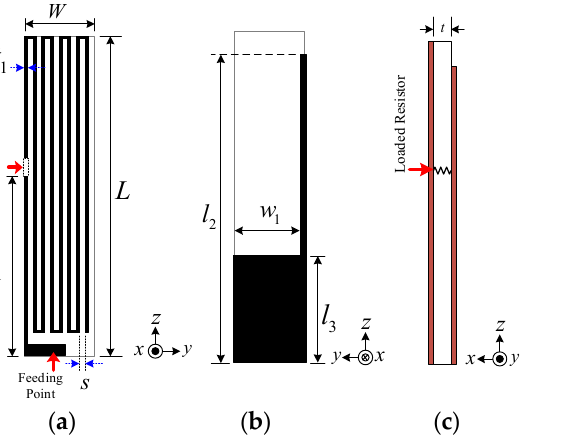
Figure 2. Structure of the MICS/ISM meander-line microstrip antenna: ( a ) front view, ( b ) rear view, ( c ) side view. Table 2. Parameters of the proposed MICS/ISM meander-line microstrip antenna.